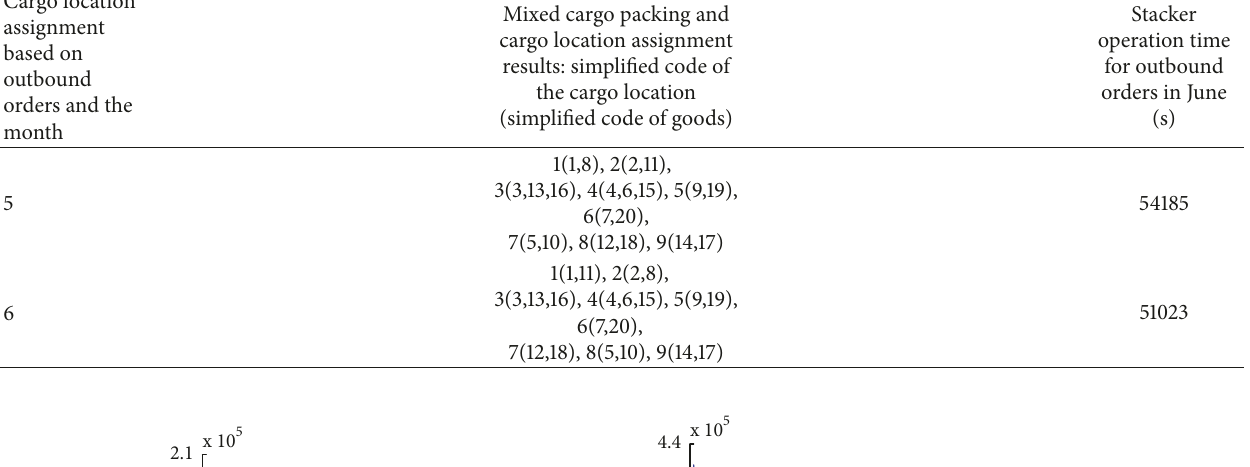
Table 9: Analysis of the impact of order changes on the optimization results.